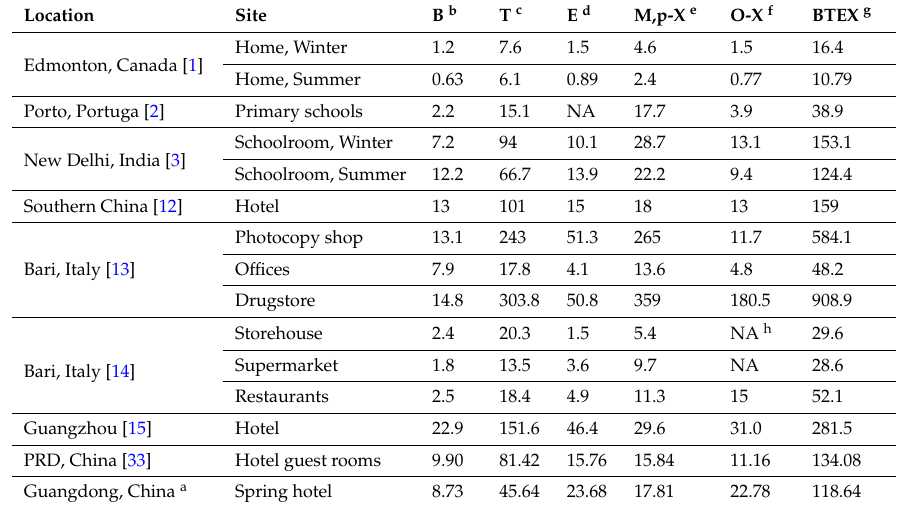
Table 4. Comparison of the mean concentrations of indoor BTEX in different indoor microenvironments, µ g ¨ m ´ 3